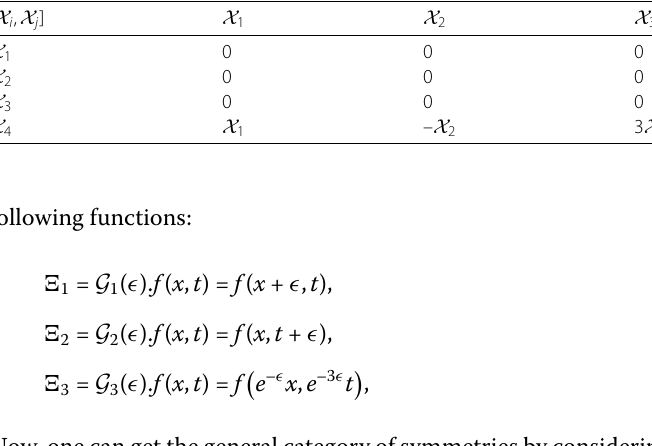
Table 1 The commutation relations of infinitesimal generators X 1 , X 2 , X 3 [ X i , X j ] X